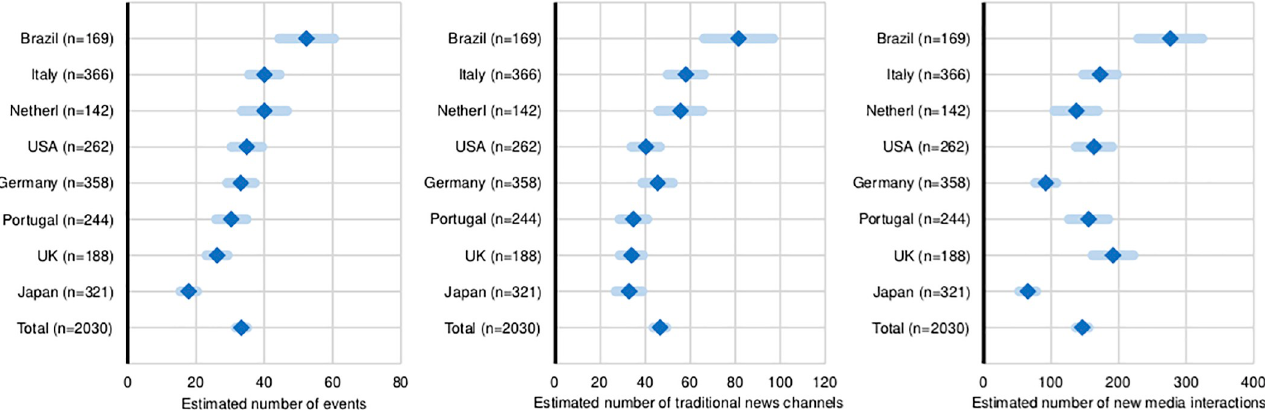
Fig 1. Frequency of public communication activity compared across countries. Estimated average number of public events, traditional news media, and new media channels by research institutes, in the twelve months prior to the study. ( N = 2,030).